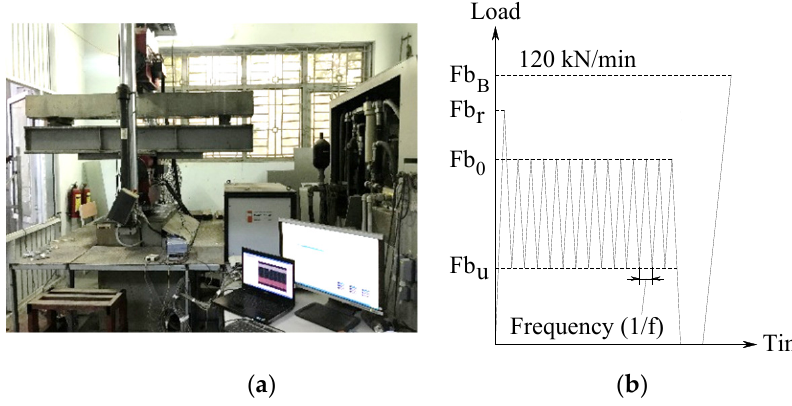
Figure 11. Fatigue test setup. ( a ) Experimental setup; ( b ) Frequency and load.